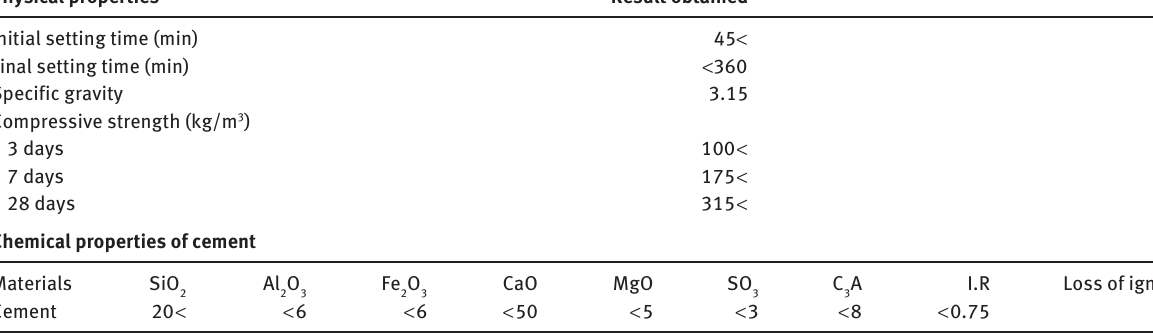
Table 1 Physical and chemical properties of